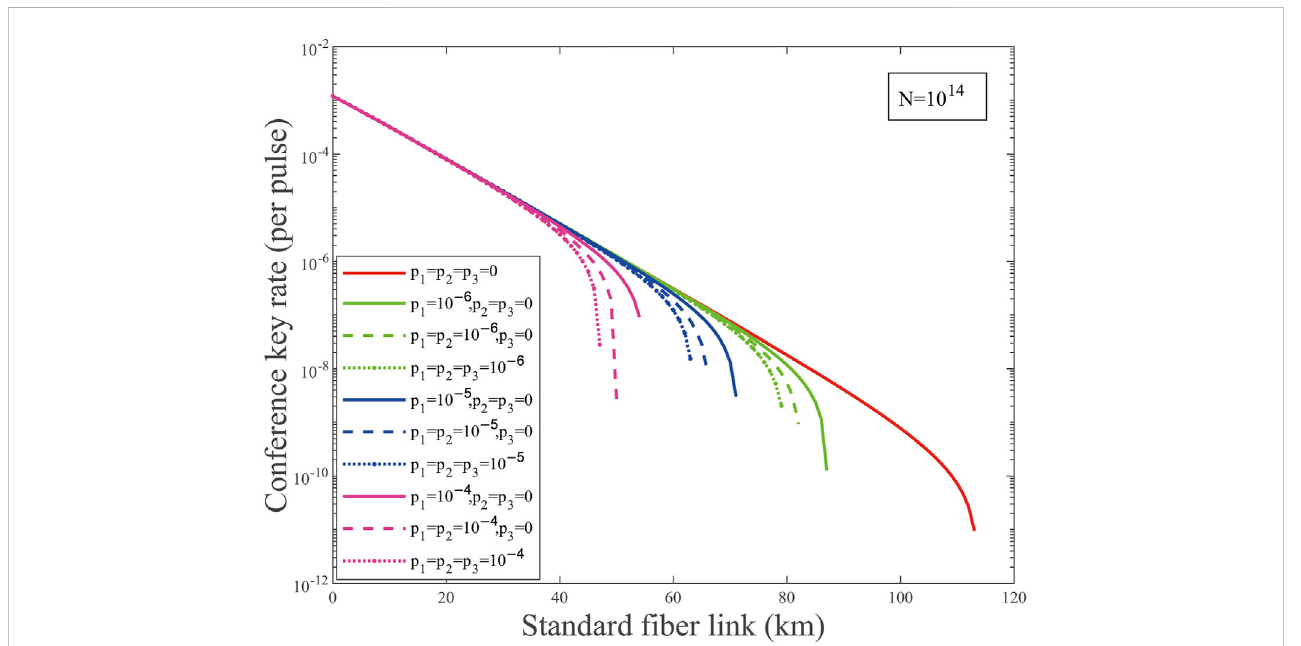
FIGURE 2 (Color online) Conference key rate (per pulse) on a logarithmic scale vs. transmission distance for p 1,2,3 = 0, 10 − x ( x = 6, 5, 4) and the total number of transmitted signals N = 10 14 . The solid lines are the results of weak randomness existing in one party, the dashed lines are the results of weak randomness existing in two parties, and the dotted lines are the results of weak randomness existing in three parties.